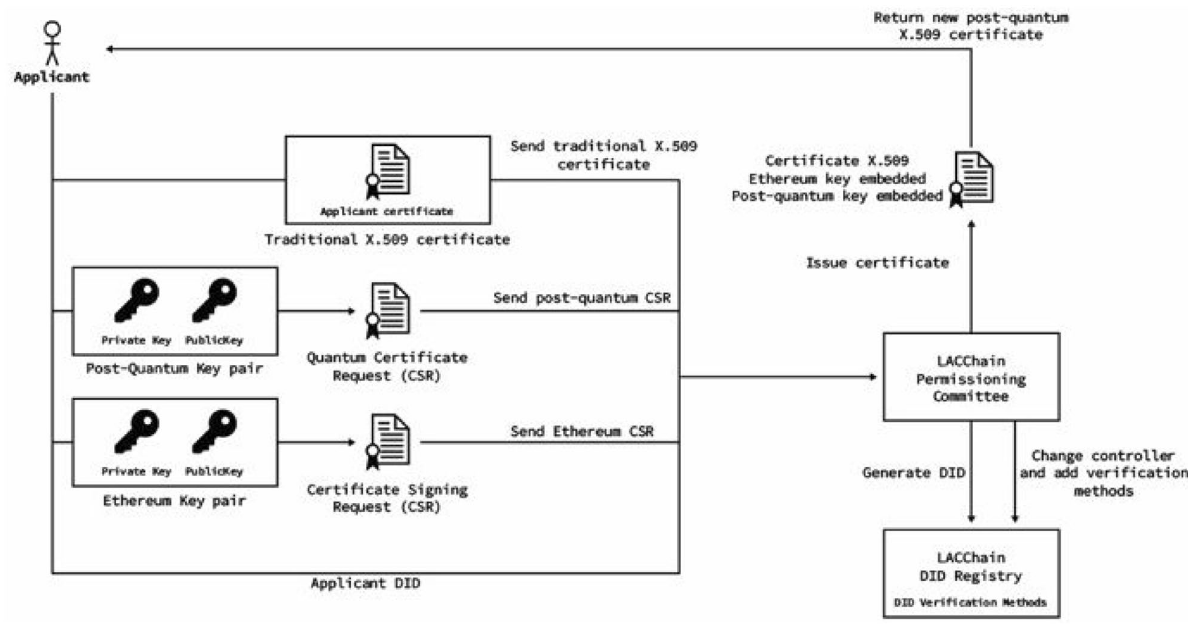
Figure 5. High level diagram of the post-quantum certification and on-chain registration of an entity.